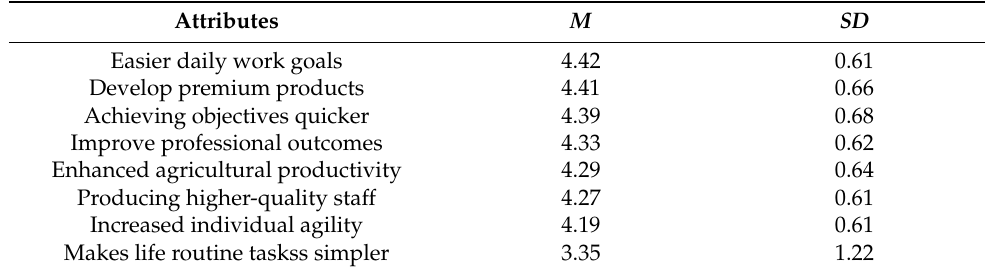
Table 2. Relative Advantage’s Innovation Metrics ( n =